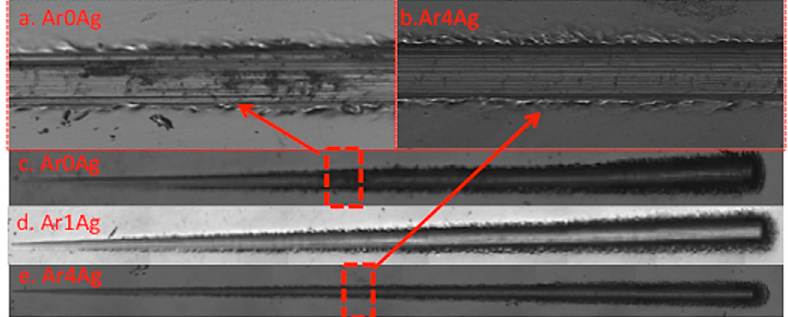
Figure 5. Micrographs of the wear track produced by the scratch tester in coatings deposited in an inert atmosphere: ( a , c ) Ar0Ag film; ( b , e ) Ar4Ag film; ( d ) Ar1Ag film.